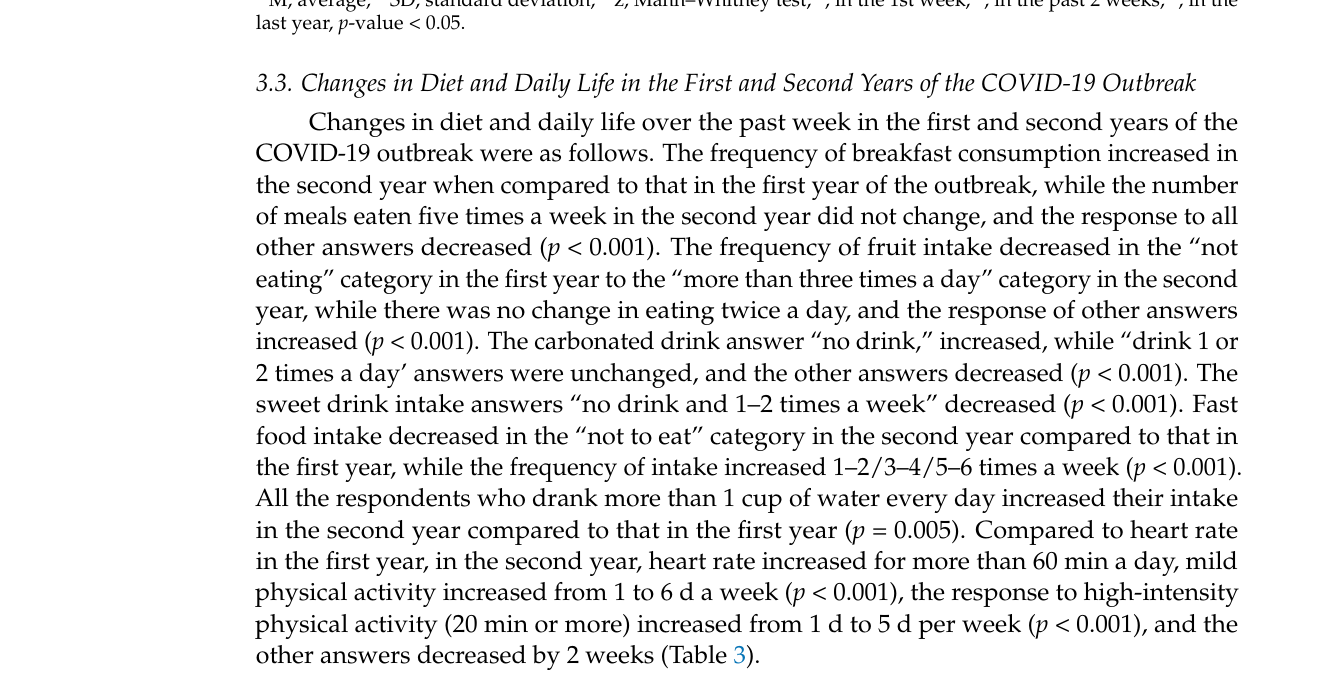
Table 3. Changes in diet and daily life in the first and second years of the COVID-19